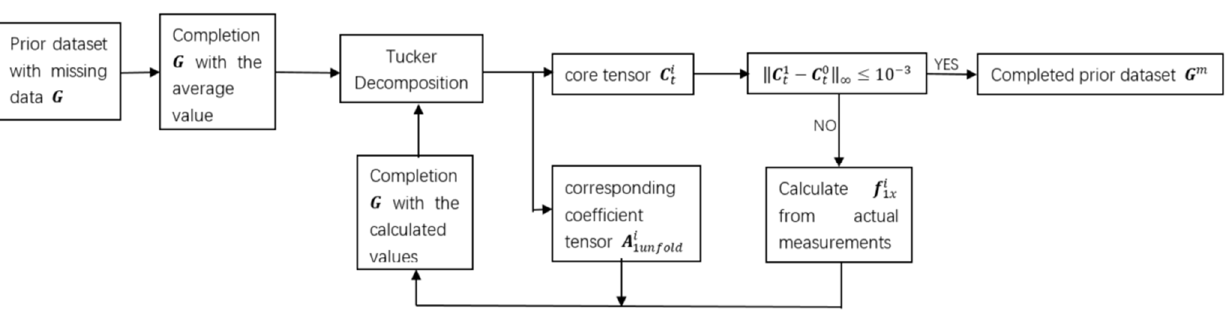
Figure 1. Flow diagram of prior dataset completion.